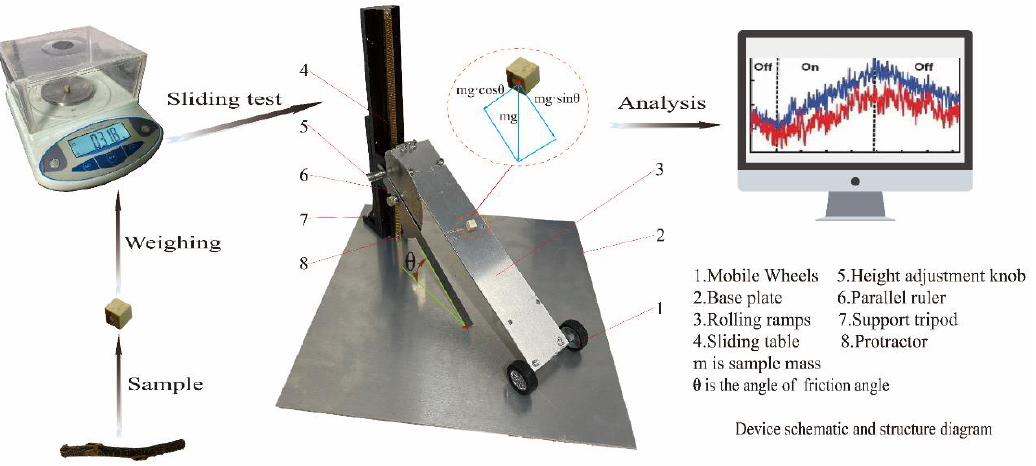
Figure 5. Friction coefficient device and determination process.